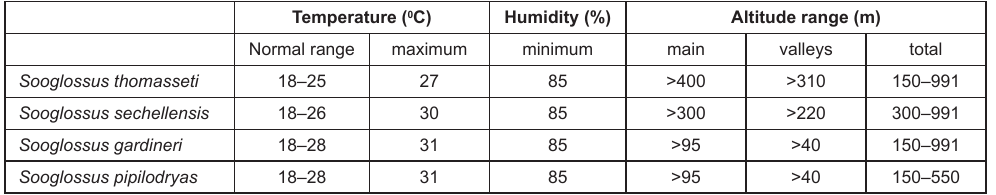
Table 2. Altitude and climate ranges for the four species in the family Sooglossidae